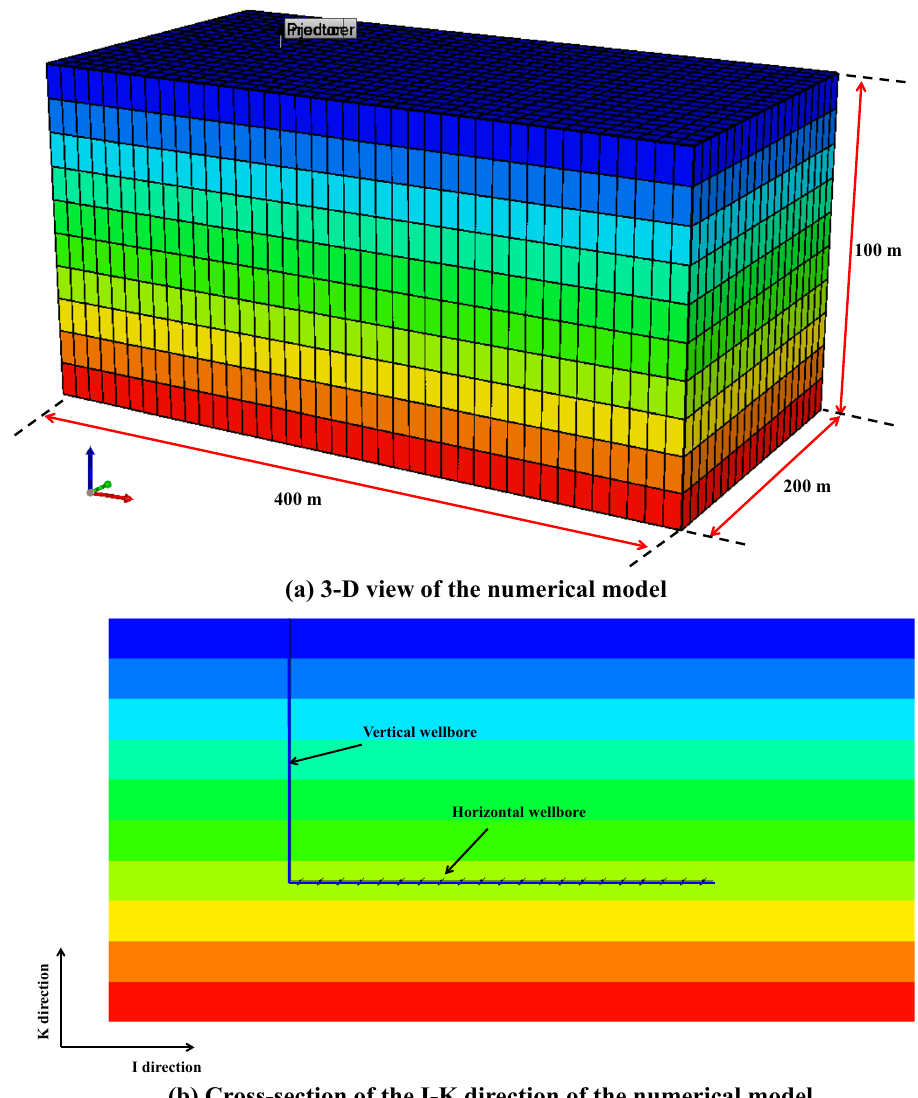
Fig. 5 Basic relationships used in the numerical